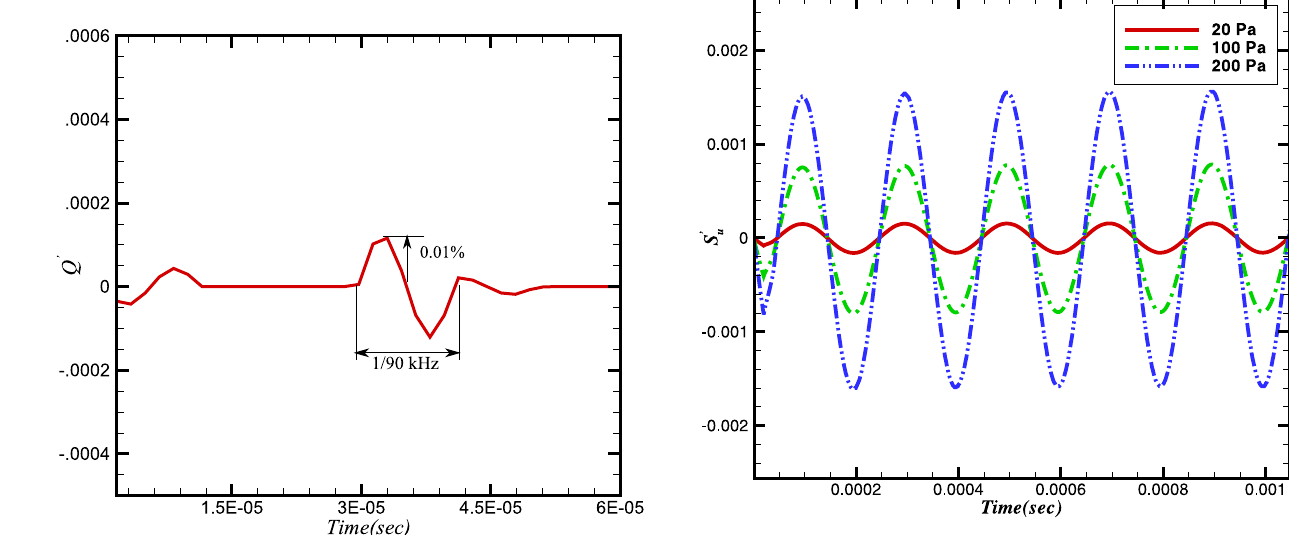
Figure 7. Relative change in heat release.